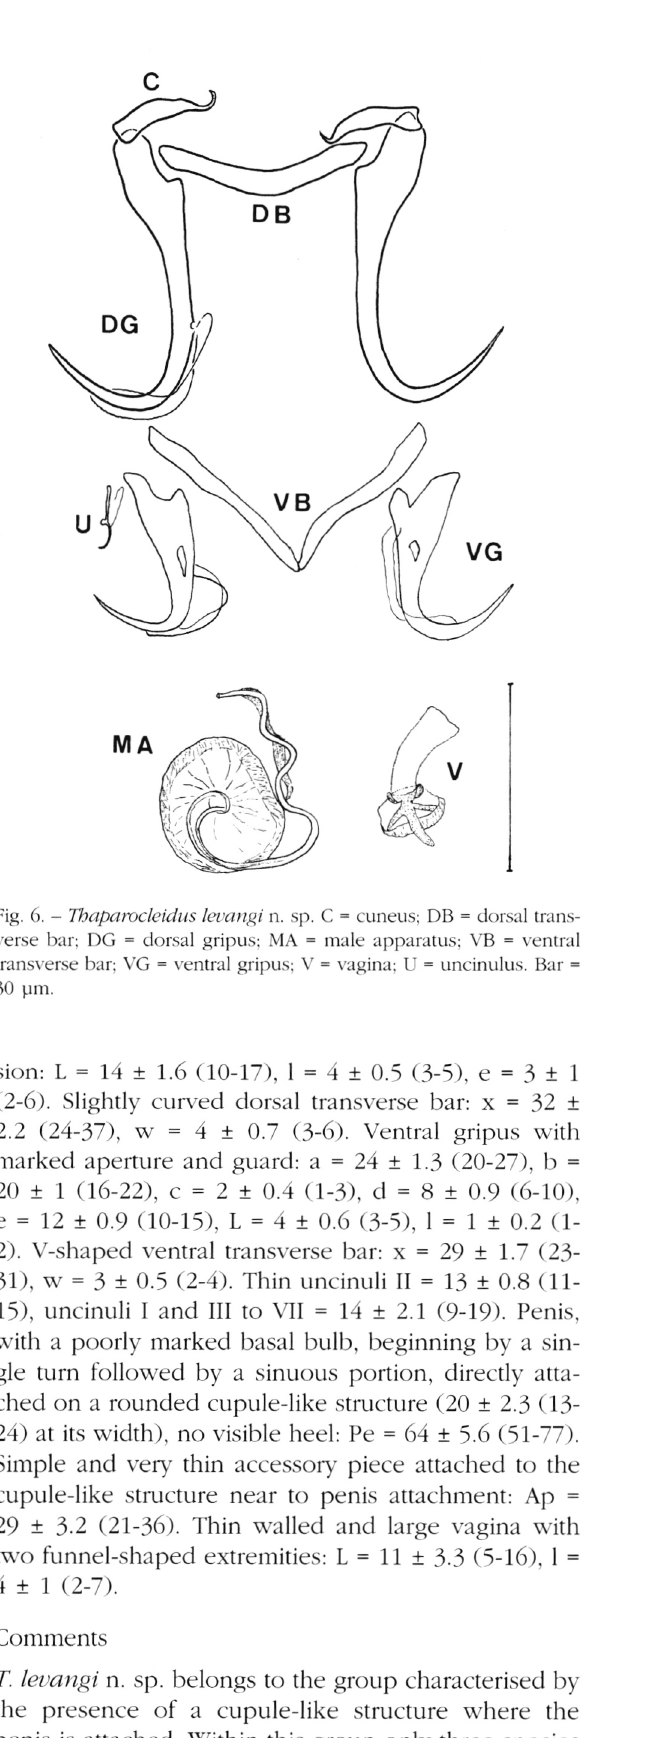
Sion: L = 14 ± 1.6 (10-17), 1 = 4 ± 0.5 (3-5), e = 3 ± 1 (2-6). Slightly curved dorsal transverse bar: x = 32